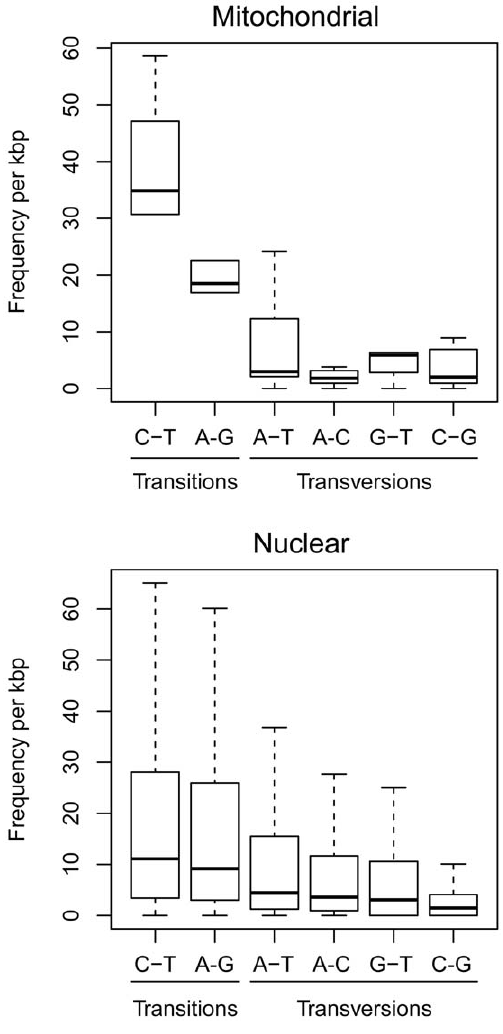
Figure 4. Frequency of transversions and transitions among high-quality mitochondrial and nuclear SNPs. Statistical outliers (values $ 1.5 6 the interquartile range) are omitted.